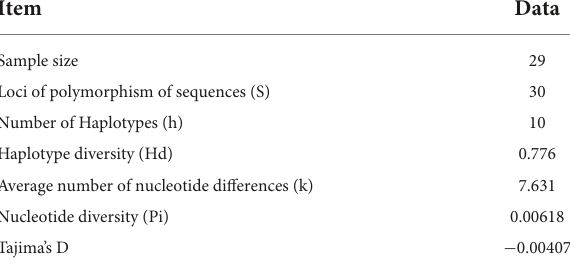
TABLE 3 The genetic diversity of Anjian chickens.